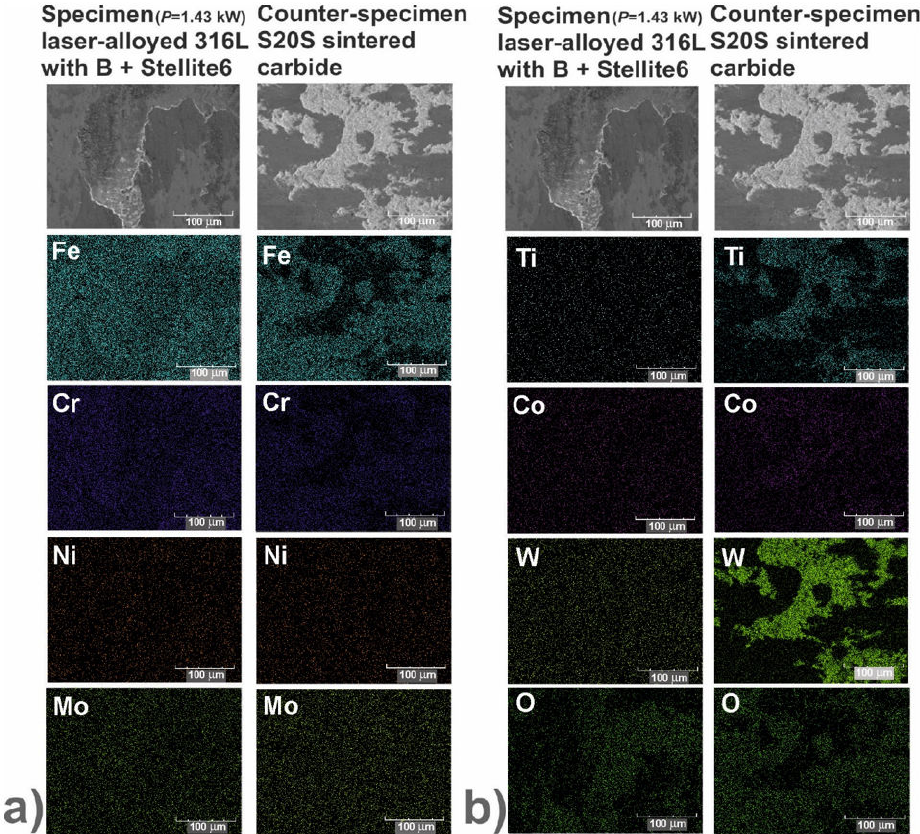
Figure 9. Worn surfaces of laser-alloyed specimen with boron and Sellite-6 using a dilution ratio of 0.41 ( P = 1.43 kW) and counter-specimen (S20S sintered carbide). ( a ) EDS patterns of the elements characteristic of the specimen as well as ( b ) the counter-specimen, taking into account oxygen concentration. Two-hour wear test with the change of counter-specimen every at 0.5